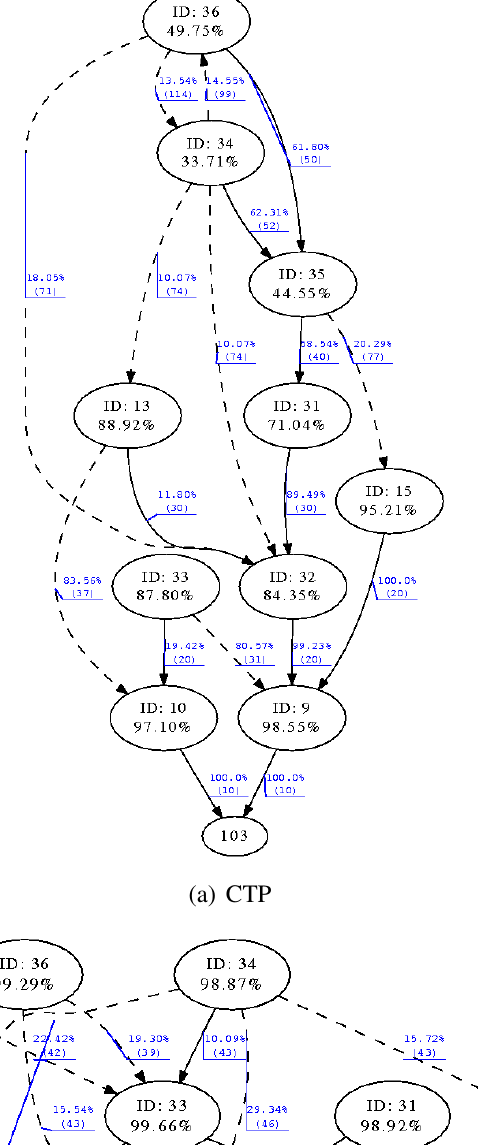
Figure 10. Routing topology created by CTP and ZERO for 11 motes and the same physical